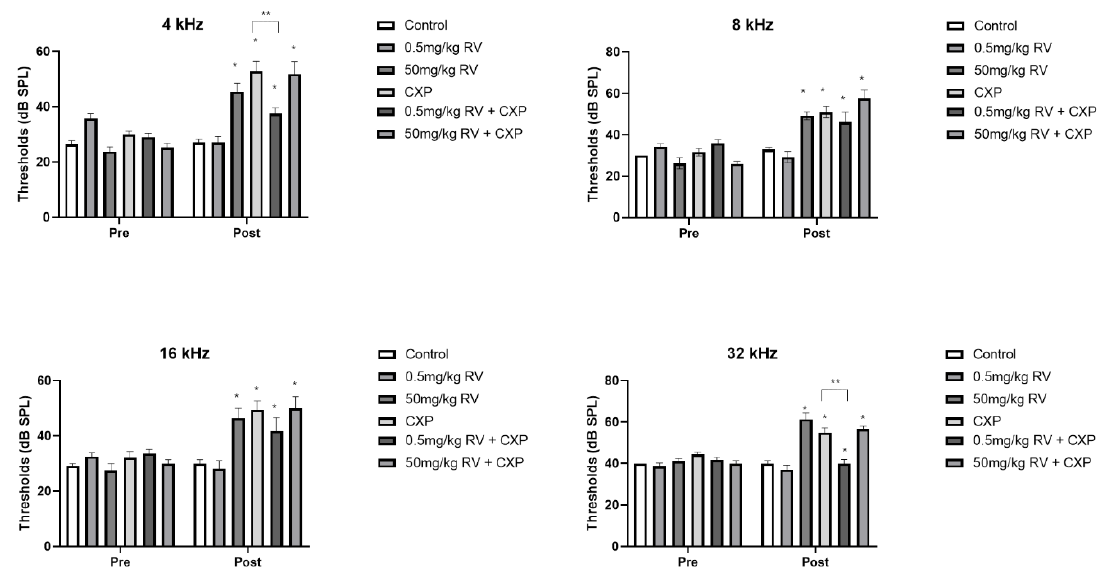
Figure 1. The auditory brainstem response thresholds of each group. The 50 mg/kg RV + CXP group demonstrated increased hearing thresholds that were not significantly different from those of the CXP group. In the 0.5 mg/kg RV + CXP group. the hearing thresholds after drug administration were lower than those of the CXP group at 4 and 32 kHz (* p < 0.05, pre- vs. post-treatment, ** p < 0.05, CXP vs. 0.5 mg/kg RV + CXP groups).